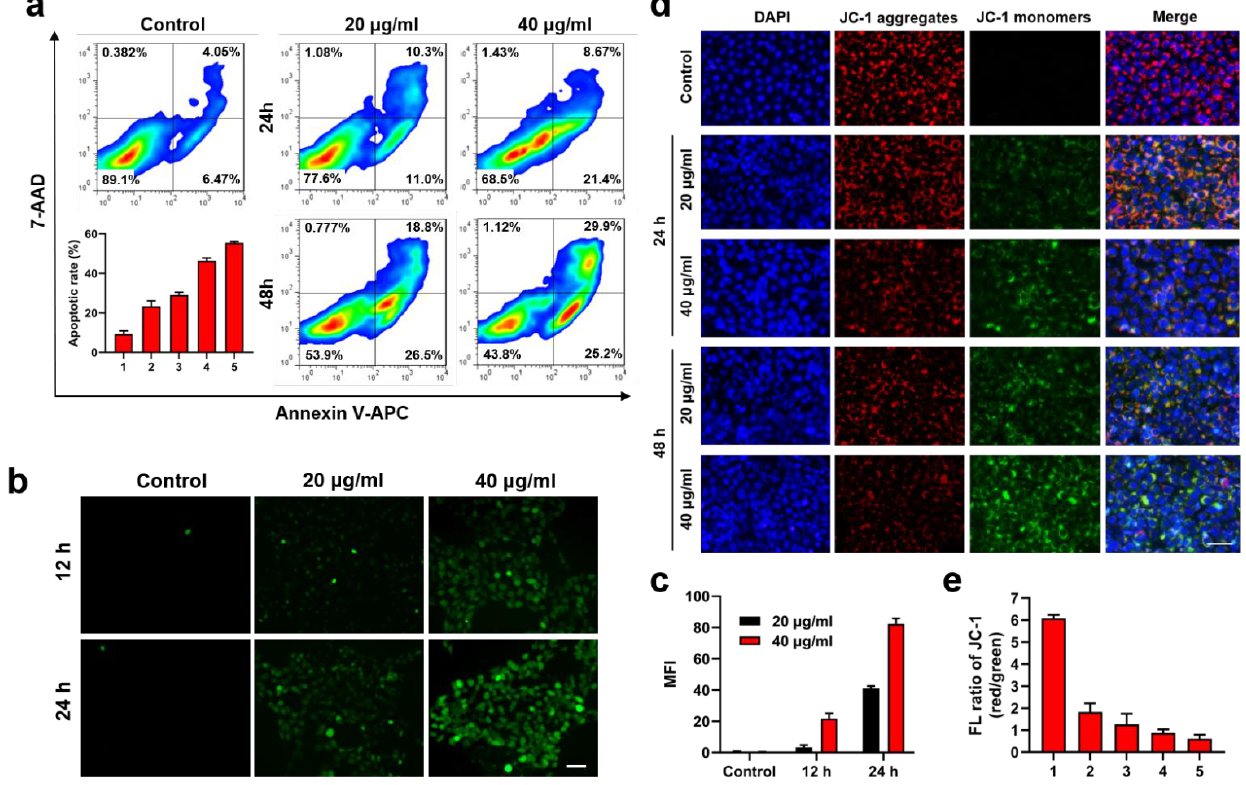
Figure 3. BMVE induces apoptosis in 4T1 cells. ( a ) Representative images and quantitative statistics of flow cytometry detection of 20 and 40 µ g/mL BMVE induced apoptosis in 4T1 cells at 24 and 48 h. ( b ) Representative images and ( c ) quantitative statistics of intracellular ROS level in 4T1 cells treated with 0, 20 and 40 µ g/mL BMVE at 12 and 24 h, which was detected by DCFH-DA and observed by fluorescence microscopy (scale bar = 50 µ m). ( d ) Representative images and ( e ) quantitative statistics of ΔΨm. Samples of 4T1 cells were treated with 20 and 40 μg /mL BMVE for 24 and 48 h, then stained with JC-1 (red and green) and DAPI (blue) dye and observed by fluorescence microscopy (scale bar = 50 μm). 1: Control; 2: 24 h- 20 μg/mL; 3: 24 h - 40 μg/mL; 4: 48 h - 20 μg/mL; 5: 48 h- 40 μg/mL.